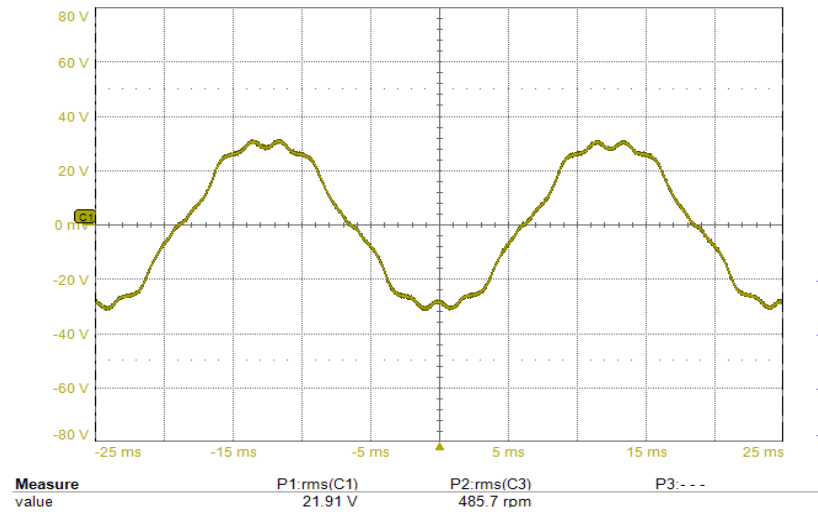
Figure 12. BEMF curve at 480 r/min. Table 9. Comparison of torque characteristics in relation to current for six-phase